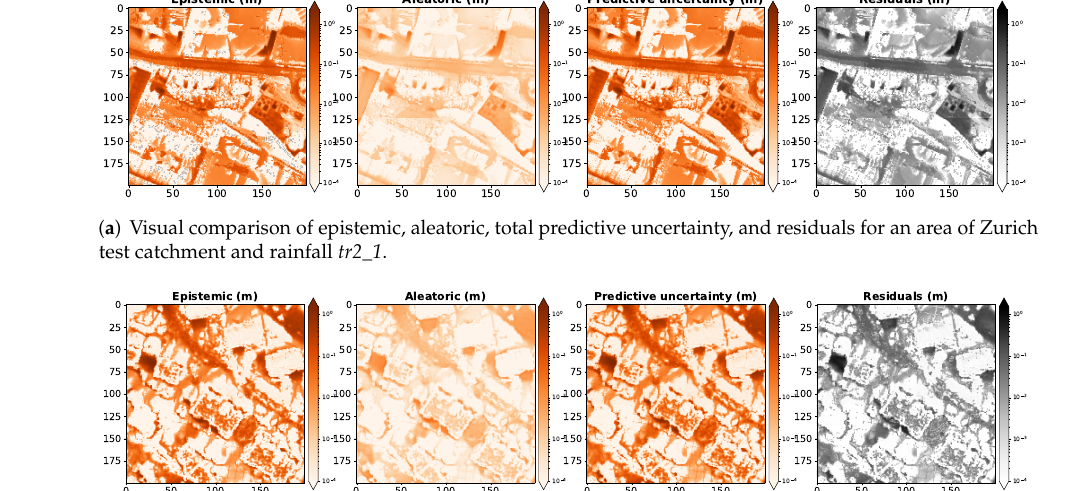
( b ) Visual comparison of epistemic, aleatoric, total predictive uncertainty, and residuals for an area of Lucerne catchment and rainfall tr2_1 .